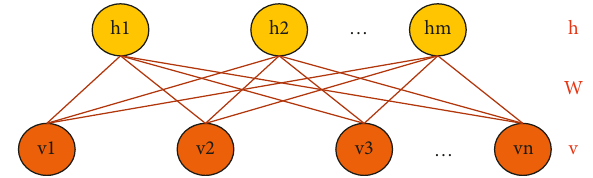
Figure 3: RBM structure